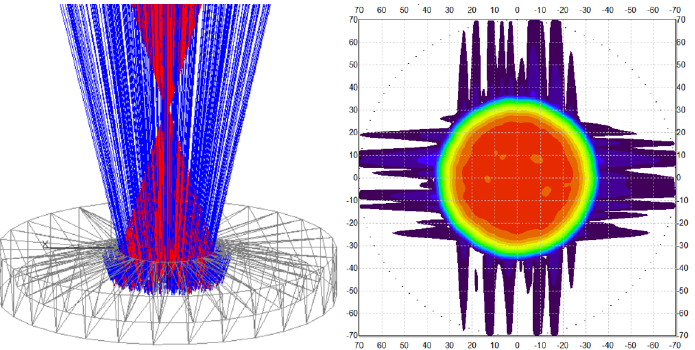
Figure 14. Ray tracing and base heat flux. Base diameter 154 mm, aperture diameter 45 mm, height 15 mm, incoming flux 1 kW, concentrated by a Fresnel lens, absorptance 85%, lateral surface reflectivity 80%, focus adjusted at 0.5 mm